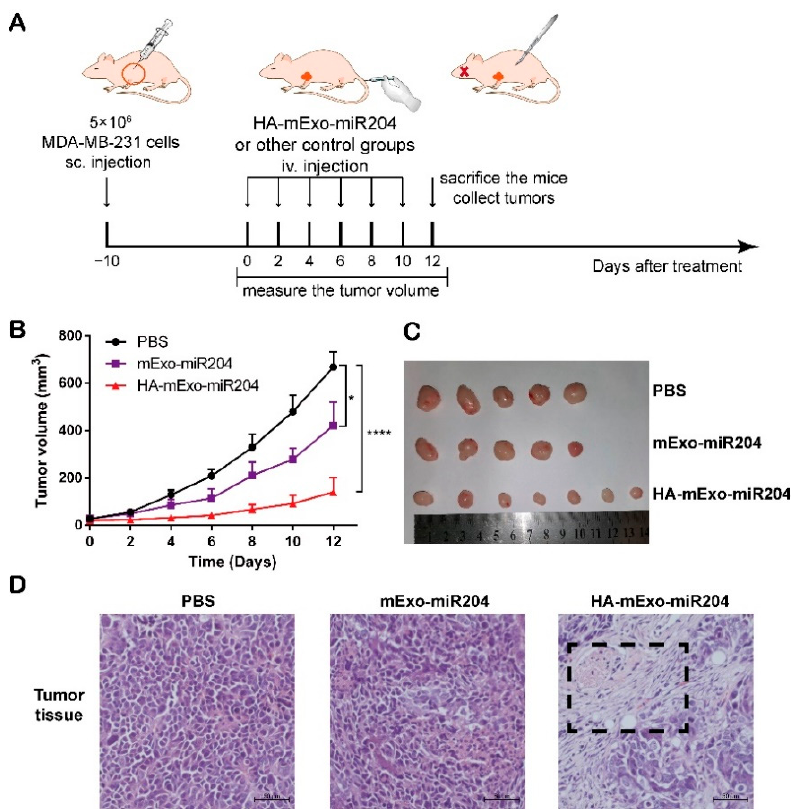
Figure 4. In vivo antitumor efficacy of HA-mExo-miR204. ( A ) Schematics of mice model construc- tion and therapeutic schedule. ( B ) Average tumor volume of mice during the therapeutic course. ( C ) Tumor images of mice after the therapy. ( D ) Histological analysis of tumor sections with HE staining. The region showing significant apoptosis was highlighted by the black dashed frame. Scale bars: 50 µ m. * p < 0.05, **** p <